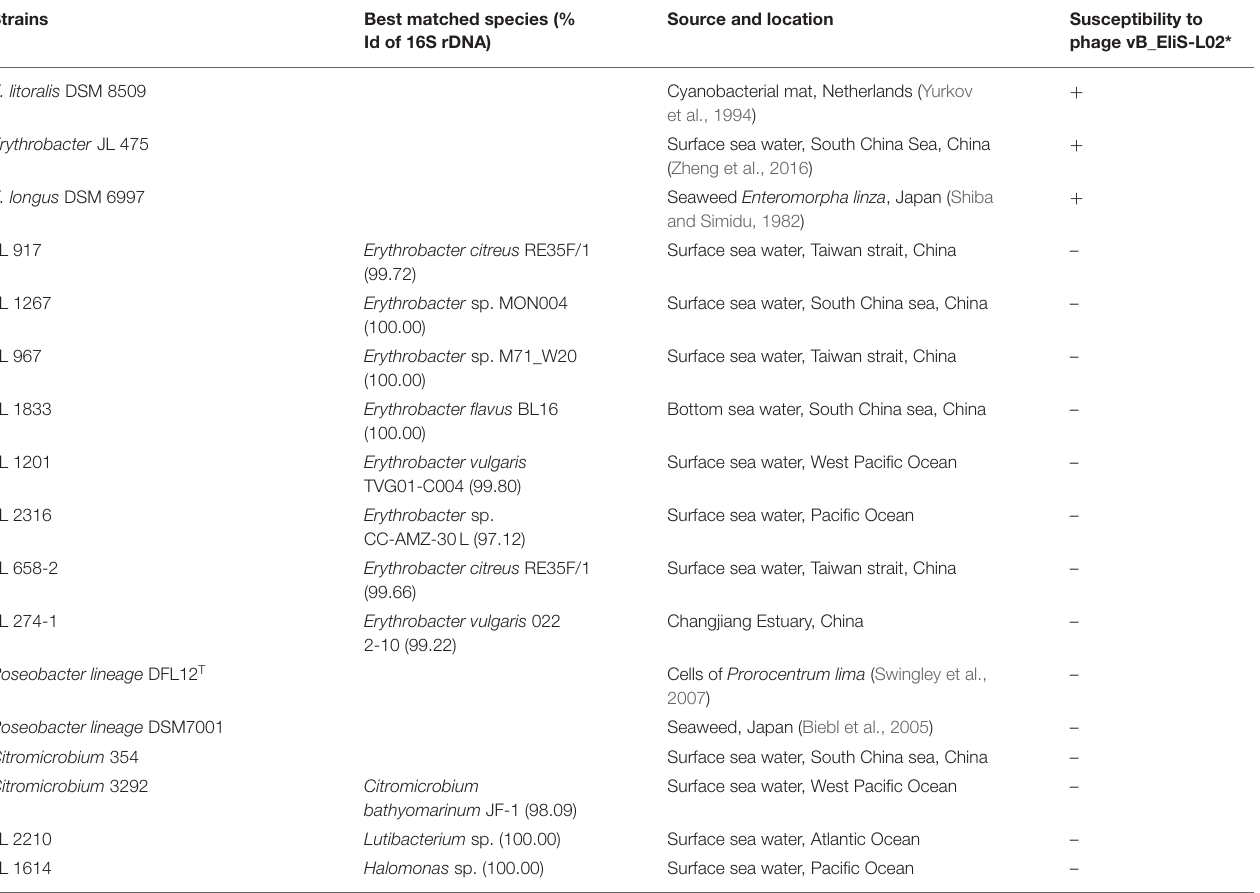
TABLE 1 | Host range of the phage vB_EliS-L02.